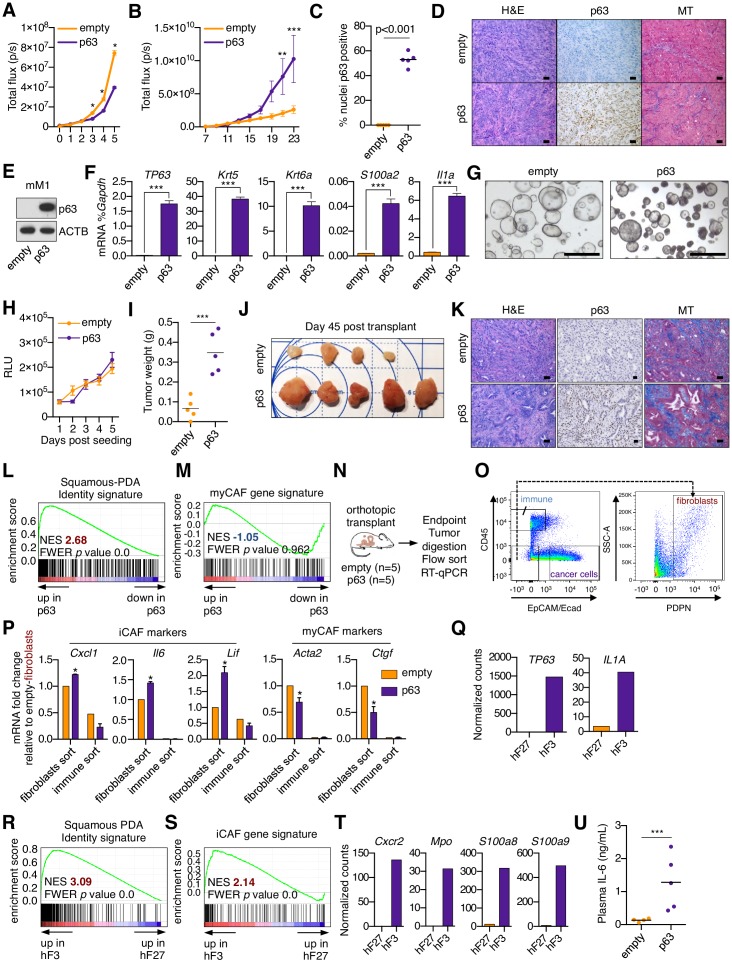
Ectopic expression of p63 in PDA cells promotes inflammation-associated transcriptional changes in the tumor microenvironment.(A) Luciferase-based quantification of SUIT2-empty and SUIT2-p63 cell proliferation in vitro. Mean ± SEM values are shown. n = 6 technical repeats. (B) Quantification of the bioluminescence signal following transplantation of SUIT2- empty or SUIT2-p63 cells to the pancreas of NSG mice. Mean ± SEM in shown. Mice were imaged every two days between day seven and 23 post-transplantation. n = 5 mice per group. (C) Quantification of p63 expression by immunohistochemical staining of tumors. p value determined by Student’s t-test. (D) Representative images from (C). MT, Masson’s trichrome. Scale bar indicates 50 μm. (E) Representative western blot analysis for ACTB and p63 in mM1-empty or mM1-p63 cells. (F) Bar chart showing RT-qPCR analysis for squamous markers (TP63, Krt5, Krt6a and S100a2) and Il1a in mM1-empty and mM1-p63 cells. Mean+ SEM is shown. n = 3. (G) Representative bright-field images of mM1 organoid cultures. (H) Quantification of in vitro cell growth measured by CellTiter-Glo. RLU, relative luminescence units. (I–J) Quantification of tumor volume (I) and images of tumors (J) on day 45 post-transplantation of mM1 organoids to the pancreas of C57BL/6 mice. ***p<0.001 by Student’s t-test. (K) Representative images from (J). MT, Masson’s trichrome. Scale bar indicates 50 μm. (L) GSEA plot evaluating the Squamous-PDA Identity signature (Somerville et al., 2018) within the human cancer cell compartment of p63-positive versus negative tumors. (M) GSEA plot evaluating the myCAF signature in the mouse stromal compartment of SUIT2-p63 versus SUIT2-empty tumors. (N–P) RT-qPCR analysis of flow-sorted tumor samples. (N) Schematic of experimental workflow. (O) Representative flow cytometry plots showing the gating strategy for enriching human cancer cells, mouse fibroblasts and mouse immune cells. (P) Bar chart showing RT-qPCR analysis for the indicated genes in the indicated sorted fraction and tumor samples. ***p<0.001, **p<0.01, *p<0.05 by two-way ANOVA with Sidak’s test for multiple comparisons. (QT) Orthotopic tumors derived from hF3 (squamous/basal) and hF27 (progenitor/classical) human tumor organoids were subjected to RNA-seq analysis of the bulk tumor tissue. (Q) TP63 and IL1A expression in the human cancer cell compartment of the tumors. (R) GSEA plot evaluating the Squamous PDA identity signature in the human cancer cell compartment of hF3 versus hF27 tumors. (S) GSEA plot evaluating the iCAF signature in the mouse stromal compartment of hF3 versus hF27 tumors. (T) Expression levels of genes preferentially expressed on neutrophils in the mouse stromal cell compartment of the hF3 and hF27 tumors. Data are from Miyabayashi et al (currently under review). (U) ELISA of IL-6 in the plasma of mice from (J) at end point. n = 4–5 mice per group. ***p<0.001 by Student’s t-test.